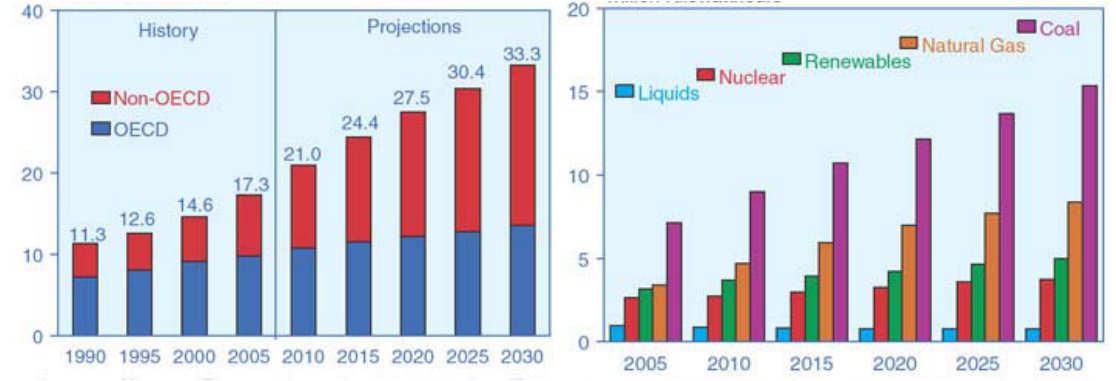
Figure 7. World electricity generation outlook (PWh), by region (left) and by fuel (right) (after